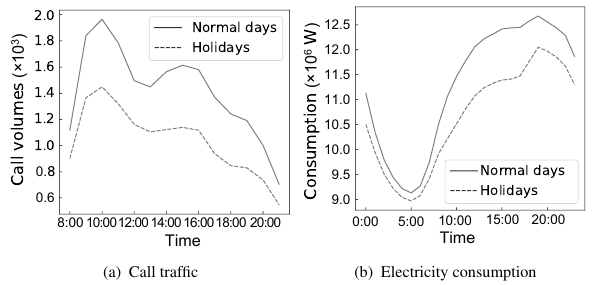
Fig. 2 Distribution differences throughout the